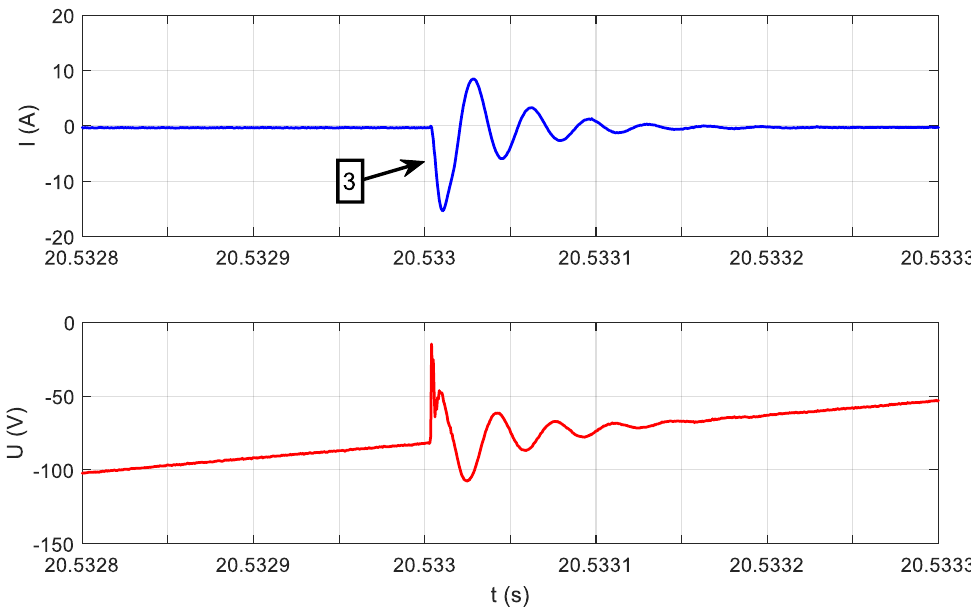
Figure 7. Moment 3, the vacuum cleaner switching on, in the scale of microseconds, transient state (TS).